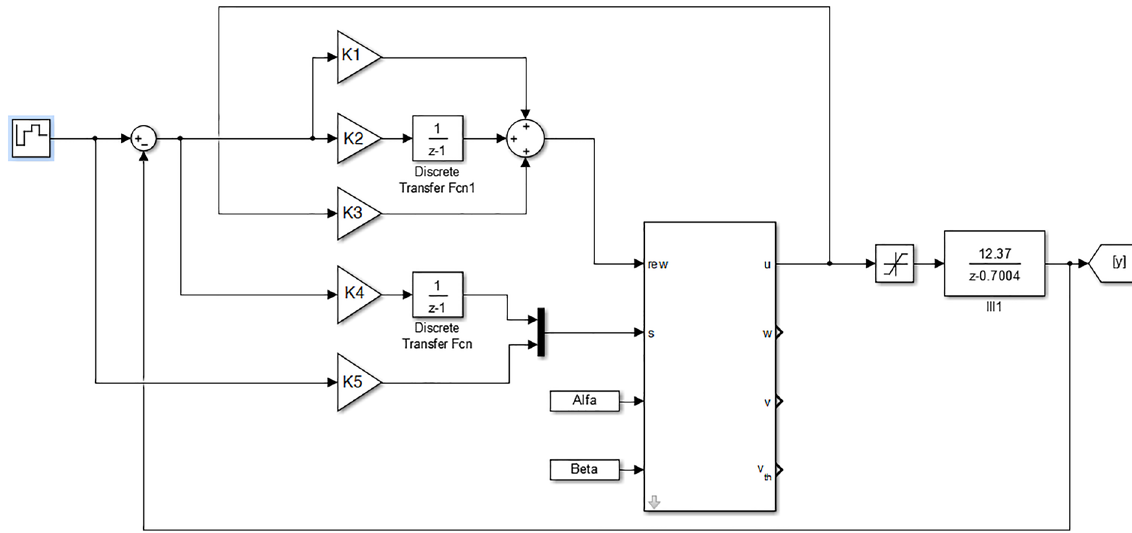
Figure 10. Control system block diagram with BELBIC